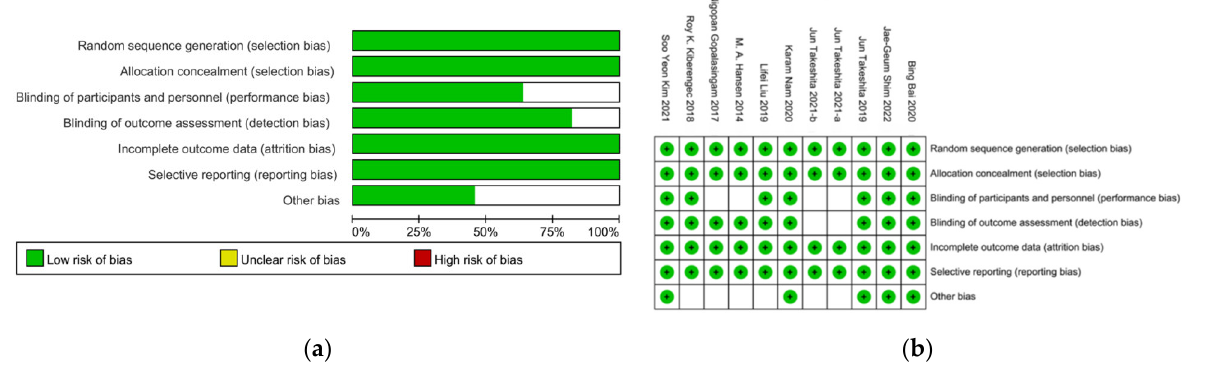
Figure 2. Risk of bias assessment in randomized controlled trial studies by RevMan. ( a ) Risk of bias graph. ( b ) Risk of bias summary [7–16]. Table 1. Main characters of included studies.